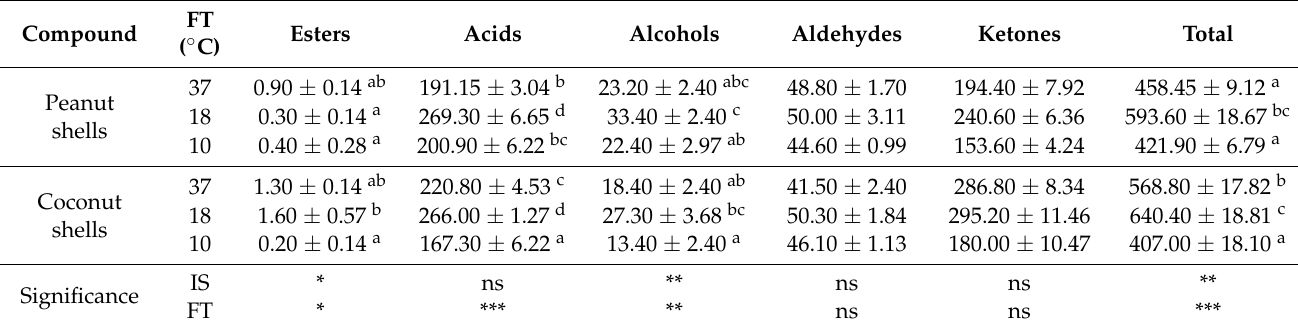
Table 5. Effect of fermentation temperature on volatile compounds ( µ g kg − 1 ) of fermented milks produced with thermally dried immobilized L. casei on peanut shells and coconut shells.